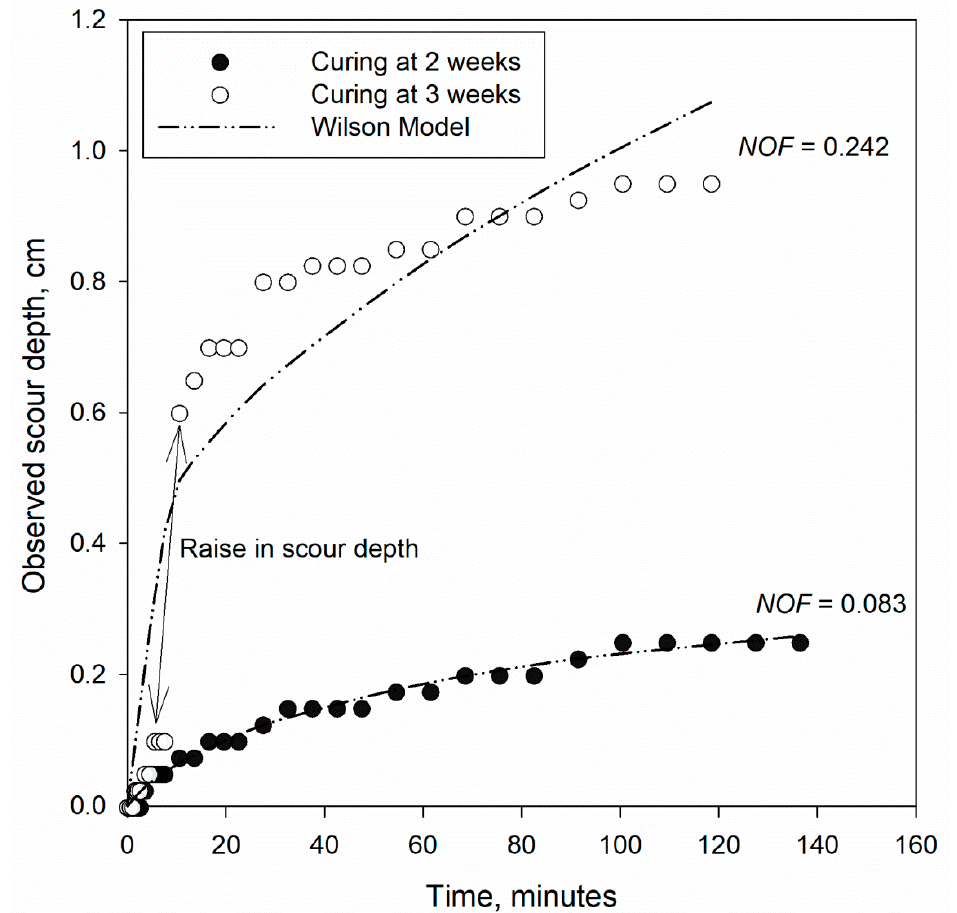
Figure 11. Comparison of scour depth readings using the mini-JET device for curing times of 2 weeks and 3 weeks for crusted soils with no humic acid and how the Wilson model fits the observed data.